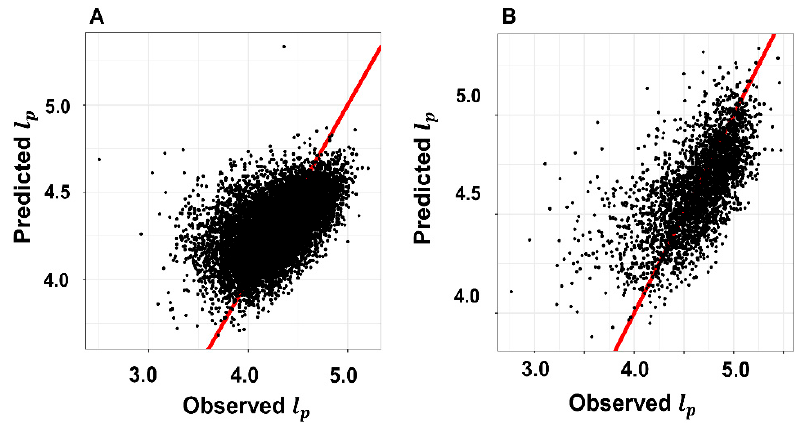
Figure 7. Predicted l p vs. Observed l p for ( A ) plant I and ( B ) plant II.